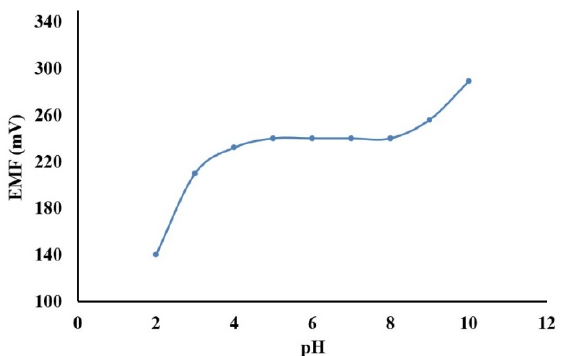
Figure 5. Effect of pH on cell potential using the electrode membrane containing o-NPOE plasticizer and two equivalents of lipophilic ion-exchanger, measured in aqueous lead(II) ion solution (10 −3 M).